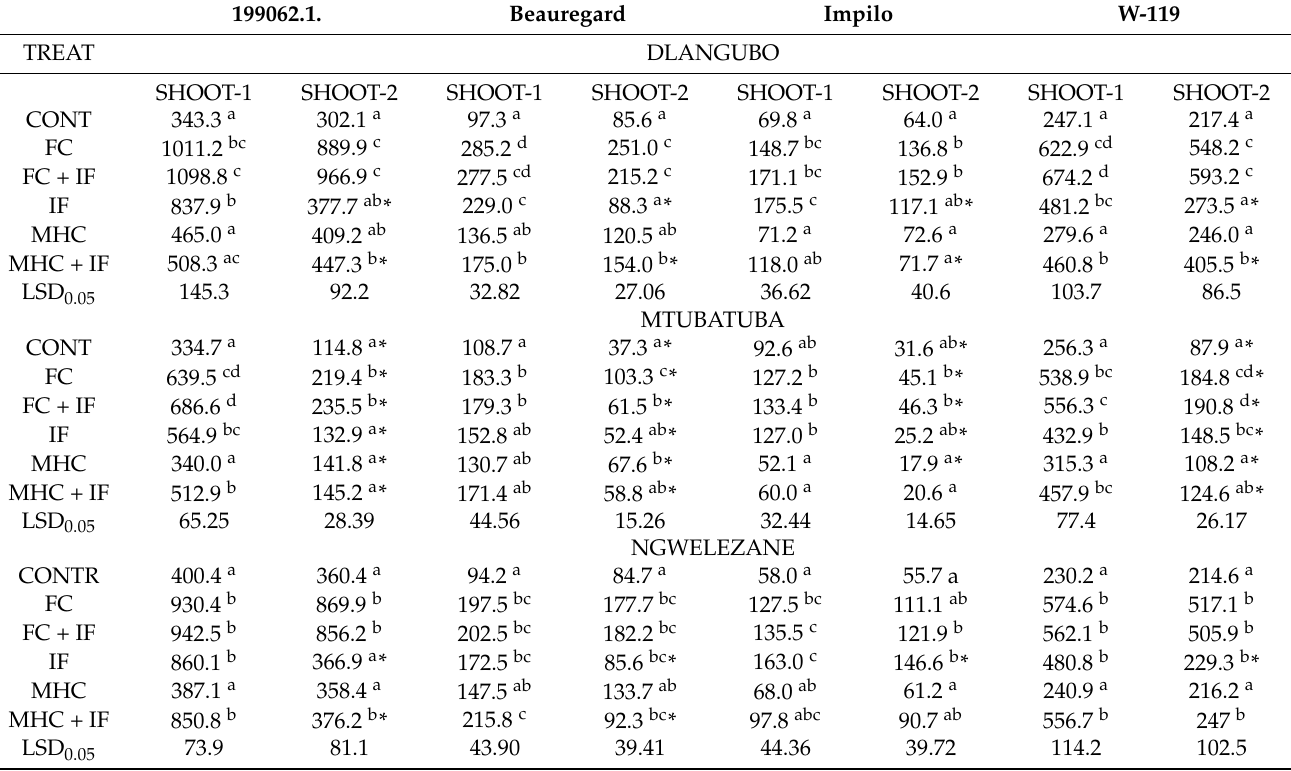
Table 4. Effects of filter cake, a combination of filter cake and inorganic fertilizer, inorganic fertilizer, macadamia compost, a combination of macadamia husk compost, and control treatments on the shoots of four orange-fleshed sweet potato cultivars grown at the Dlangubo, Ngwelezane, and Mtubatuba areas of KwaZulu-Natal Province of South Africa in seasons one (February–June)